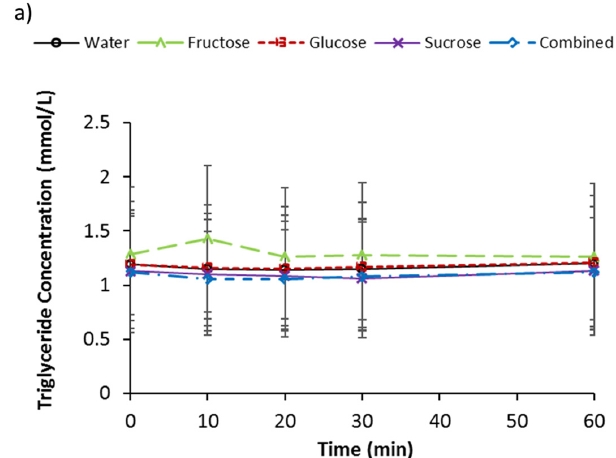
Figure 2. Serum ( a ) Insulin ( b ) glucose dependent insulinotropic polypeptide (GIP) ( c ) glucagon